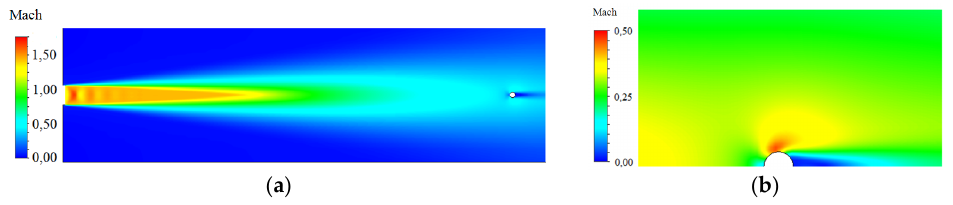
Figure 12. The Mach number distribution in the stationary jet for Р 02 (0) = 0.235 MPa at the nozzle cut: ( a ) all flow field; ( b ) flow around single tube L = 2.5m.